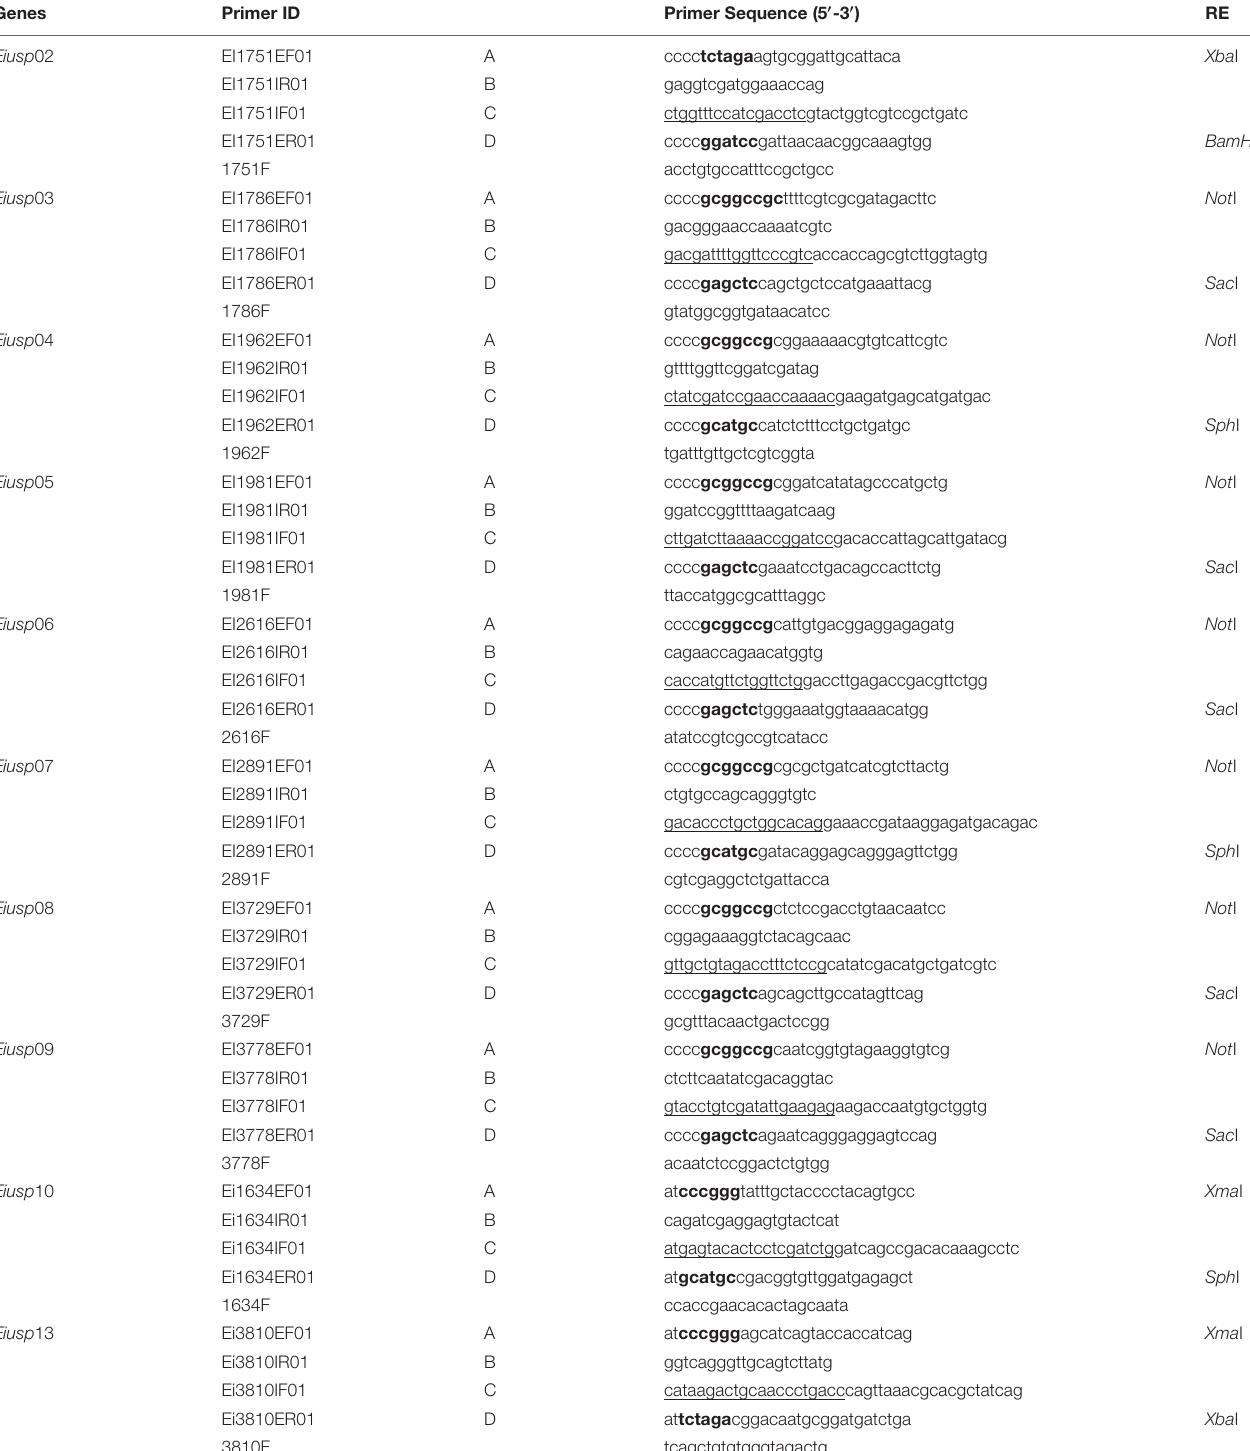
TABLE 2 | The primers used for mutant construction and sequence validation. Genes Primer ID Primer Sequence (5 (cid:48) -3 (cid:48) )